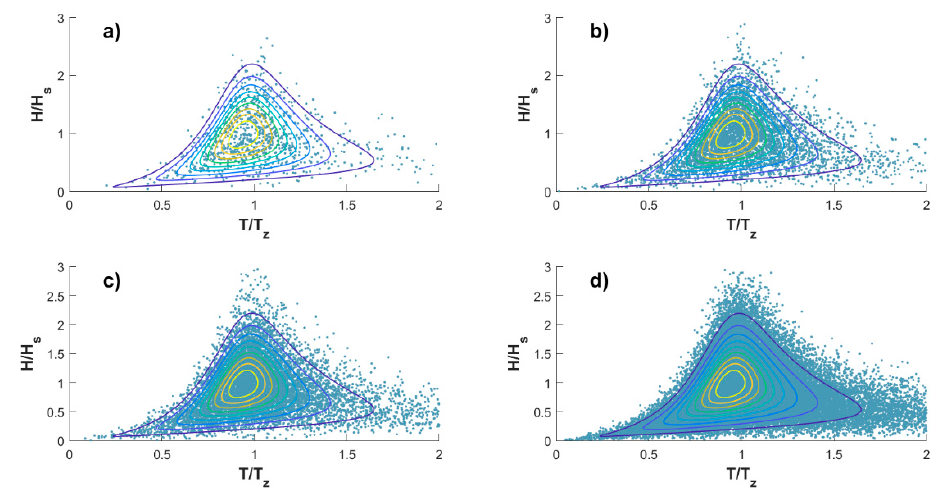
Figure 6. Randomly generated joint values of H n and T n for ( a ) 1 × 10 3 , ( b ) 5 × 10 3 , ( c ) 1 × 10 4 , and ( d ) 5 × 10 4 simulations.